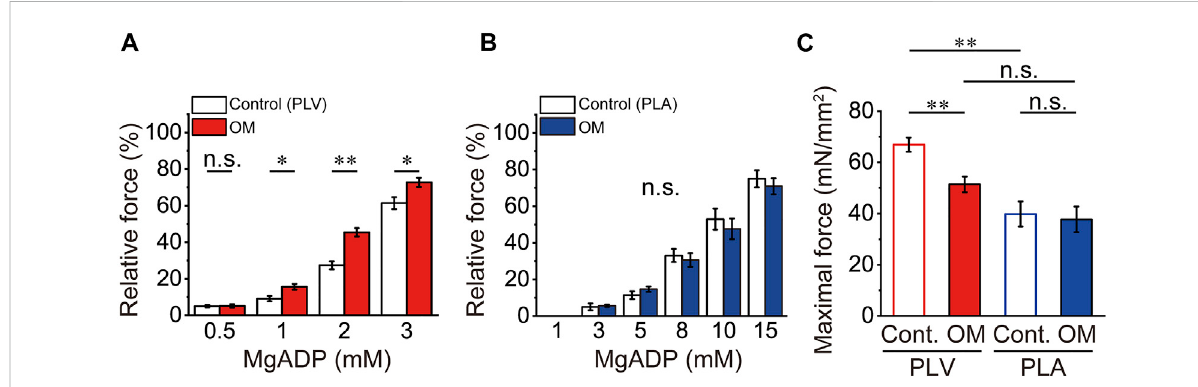
FIGURE 3 Effects of OM on ADP-contraction in PLV and PLA. (A) Graph showing the effect of 1.0 μ M OM on Ca 2+ -independent active force in PLV upon increasing the MgADP concentration at 2 mM MgATP. Note that submaximal forces at 1, 2, and 3 mM MgADP were increased in the presence of 1.0 μ M OM. * p < 0.05; ** p < 0.01 (unpaired Student ’ s t test). Submaximal forces were normalized compared with that at 20 mM MgADP with or withoutOM[see (C) ].Whiteandred,intheabsence(Control)andpresenceofOM. n =5forbothgroups. (B) Sameasin (A) forPLA.UnlikeinPLV, submaximal forces were unaffected by 1.0 μ M OM. Submaximal forces were normalized compared with that at 20 mM MgADP with or without OM [see (C) ]. White and blue, in the absence (Control) and presence of OM. n = 5 for both groups. (C) Comparison of maximal force values at 20 mM MgADP with and without 1.0 μ M OM in PLV (red) and PLA (blue). Maximal force was obtained by activating muscle at 20 mM MgADP prior to investigation of submaximal forces. ** p < 0.01 (unpaired Student ’ s t